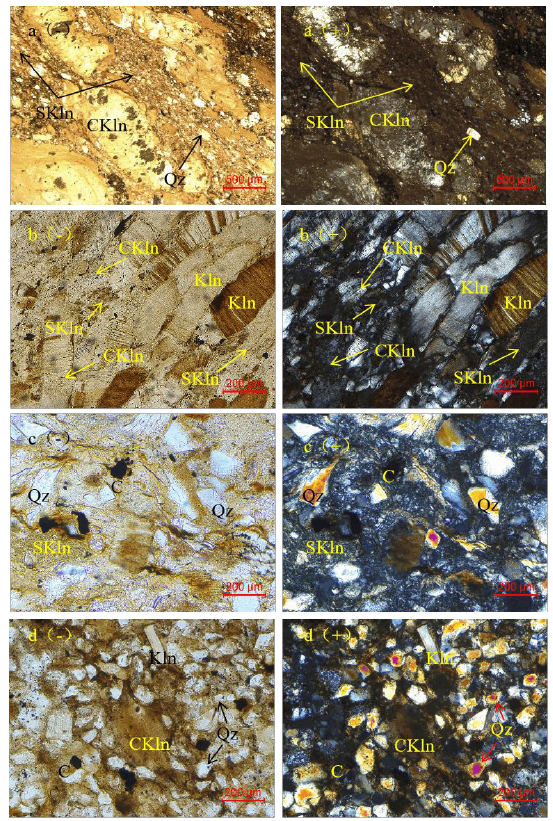
Figure 4. The plane-polarized light microscopy (Leica 2700) images of kaolinite rock samples under single polarization ( − ) and cross-polarization (+), where panels ( a ) of kaolinite rock represent sample C5G, including scaly and clastic texture kaolinite and quartz; panels ( b ) represent the sample C5F1 including scaly, clastic and flaky texture kaolinite; panels ( c ) represent sample C5F2, including scaly texture kaolin- ite, carbonaceous matrix and quartz; and panels ( d ) represent sample C8F, including clastic and flaky texture kaolinite, carbonaceous matrix and quartz. Kln, kaolinite; Qz, quartz; SKln, scaly kaolinite; CKln, clastic kaolinite; C, carbonaceous matrix. The content of quartz is clearly increased in C5F2 and C8F.